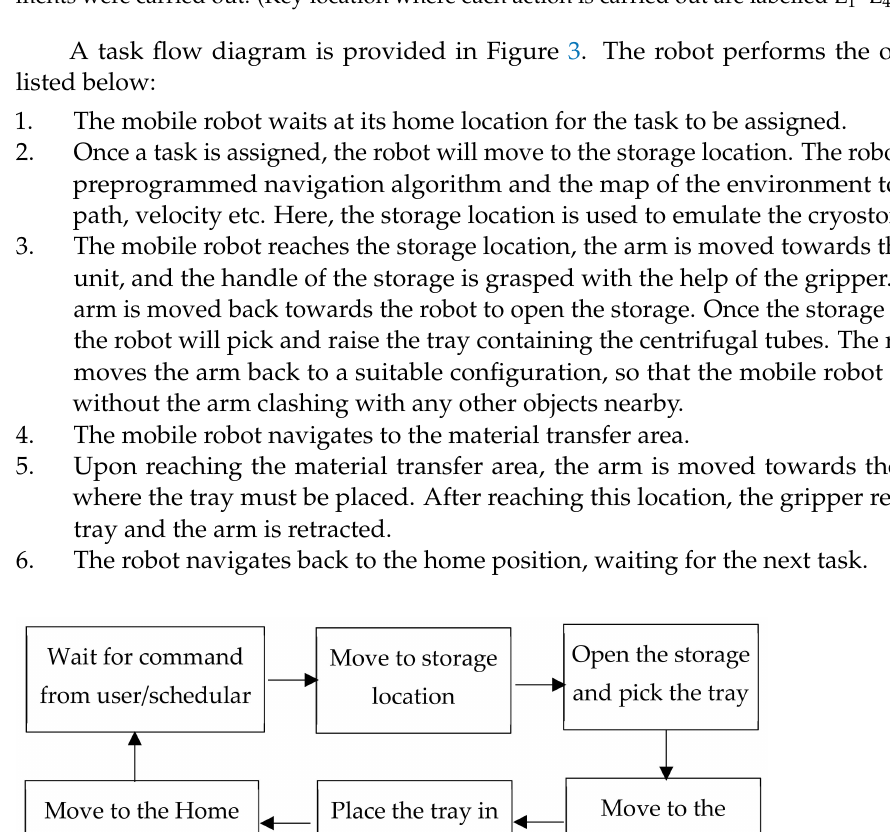
Figure 2. Photoraph and robot-generated map showing a plan view the room in which the experi- ments were carried out. (Key location where each action is carried out are labelled L 1 –L 4 ).